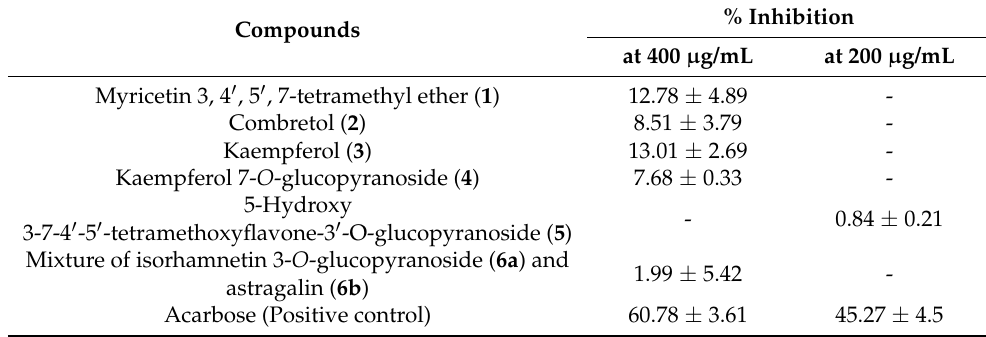
Table 2. Inhibitory activity of isolated compounds from S. stramonifolium on alpha-glucosidase. Compounds